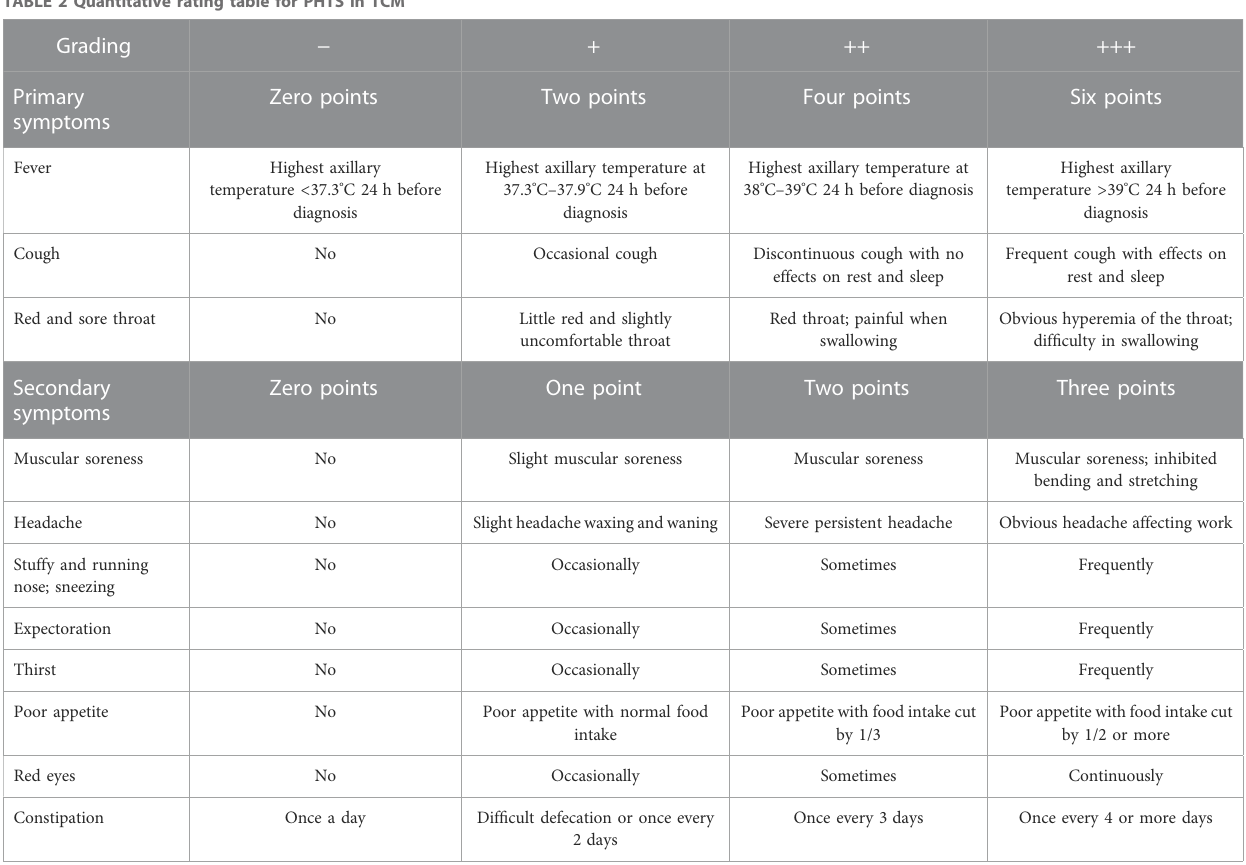
Red and sore throat